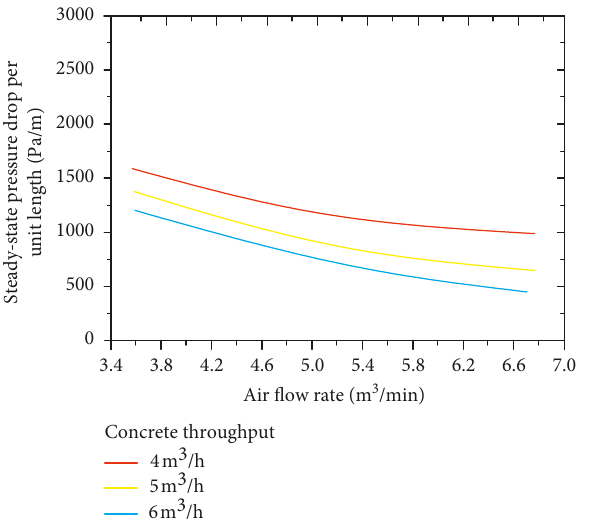
Figure 7: Variations of pressure drop in the constant speed section with air